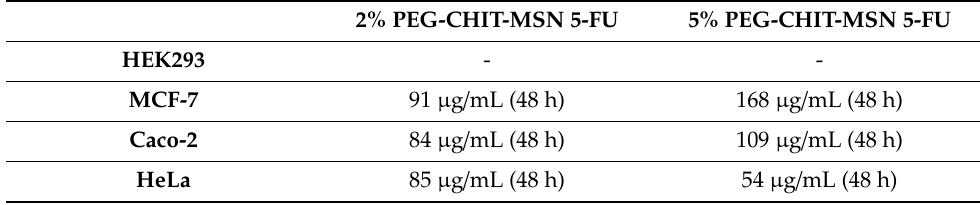
Figure 8. (a) MTT and (b) SRB cytotoxicity assay of f-MSNs and 5-FU-loaded MSNs administered at Figure 8. ( a ) MTT and ( b ) SRB cytotoxicity assay of f-MSNs and 5-FU-loaded MSNs administered at various concentrations (20, 50, and 100 μg/ mL) in HeLa cells. Data is represented as mean ± SD ( n = various concentrations (20, 50, and 100 µ g / mL) in HeLa cells. Data is represented as mean ± SD ( n = 3). 3). * p < 0.05 and ** p < 0.01 were considered statistically significant. * p < 0.05 and ** p < 0.01 were considered statistically significant. Table 7. IC 50 values of 5-FU-MSN treated tested cell lines (Figures